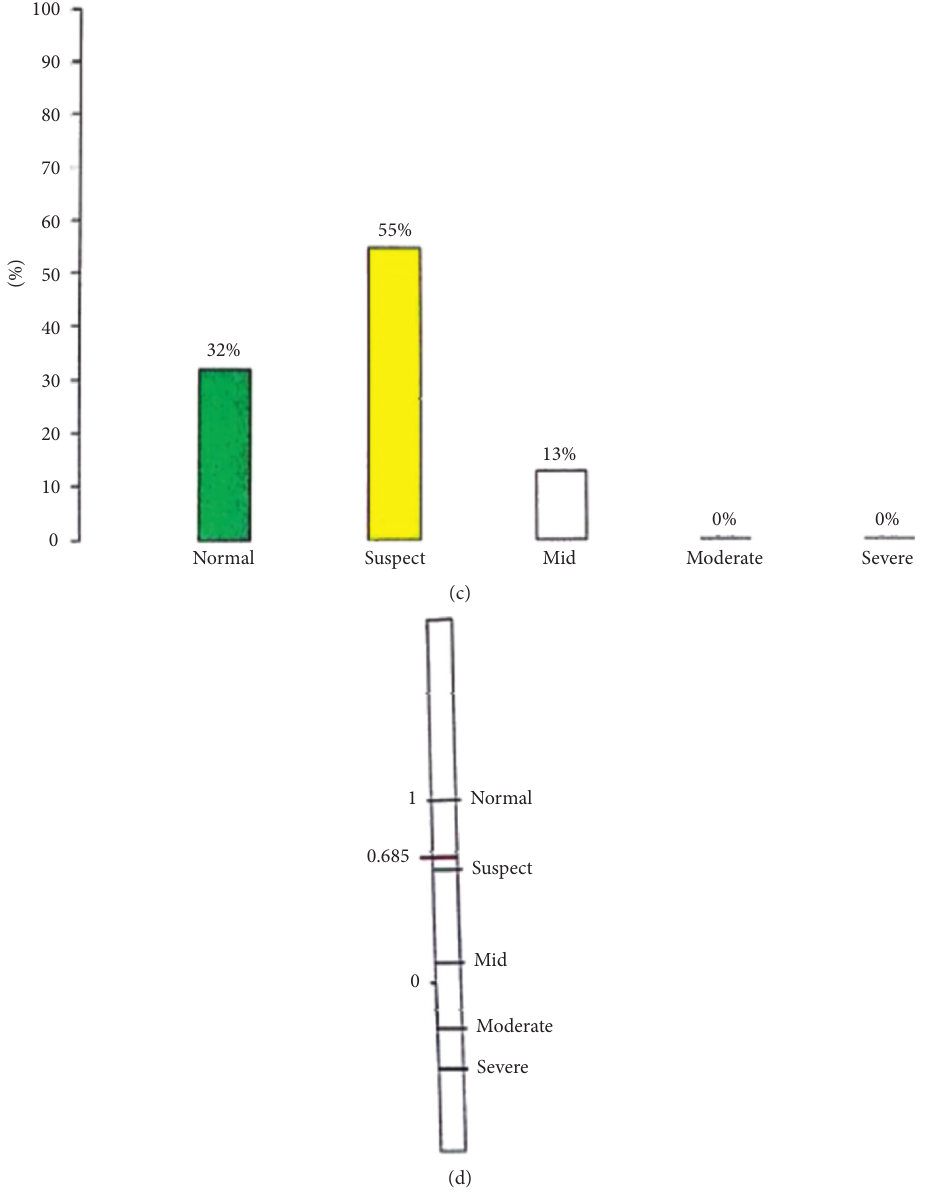
Figure 4: ORA signal of the left eye of a patient in group 1 (normal). (a) Waveform and measurement values. (b) Waveform parameters deviation from mean. (c) Keratoconus match probabilities. (d) Keratoconus match index.